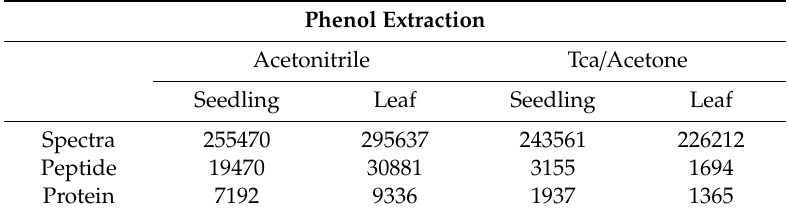
Table 1. The comparative analysis of the e ffi ciency of the protein extraction methods in seedlings and leaves of moso